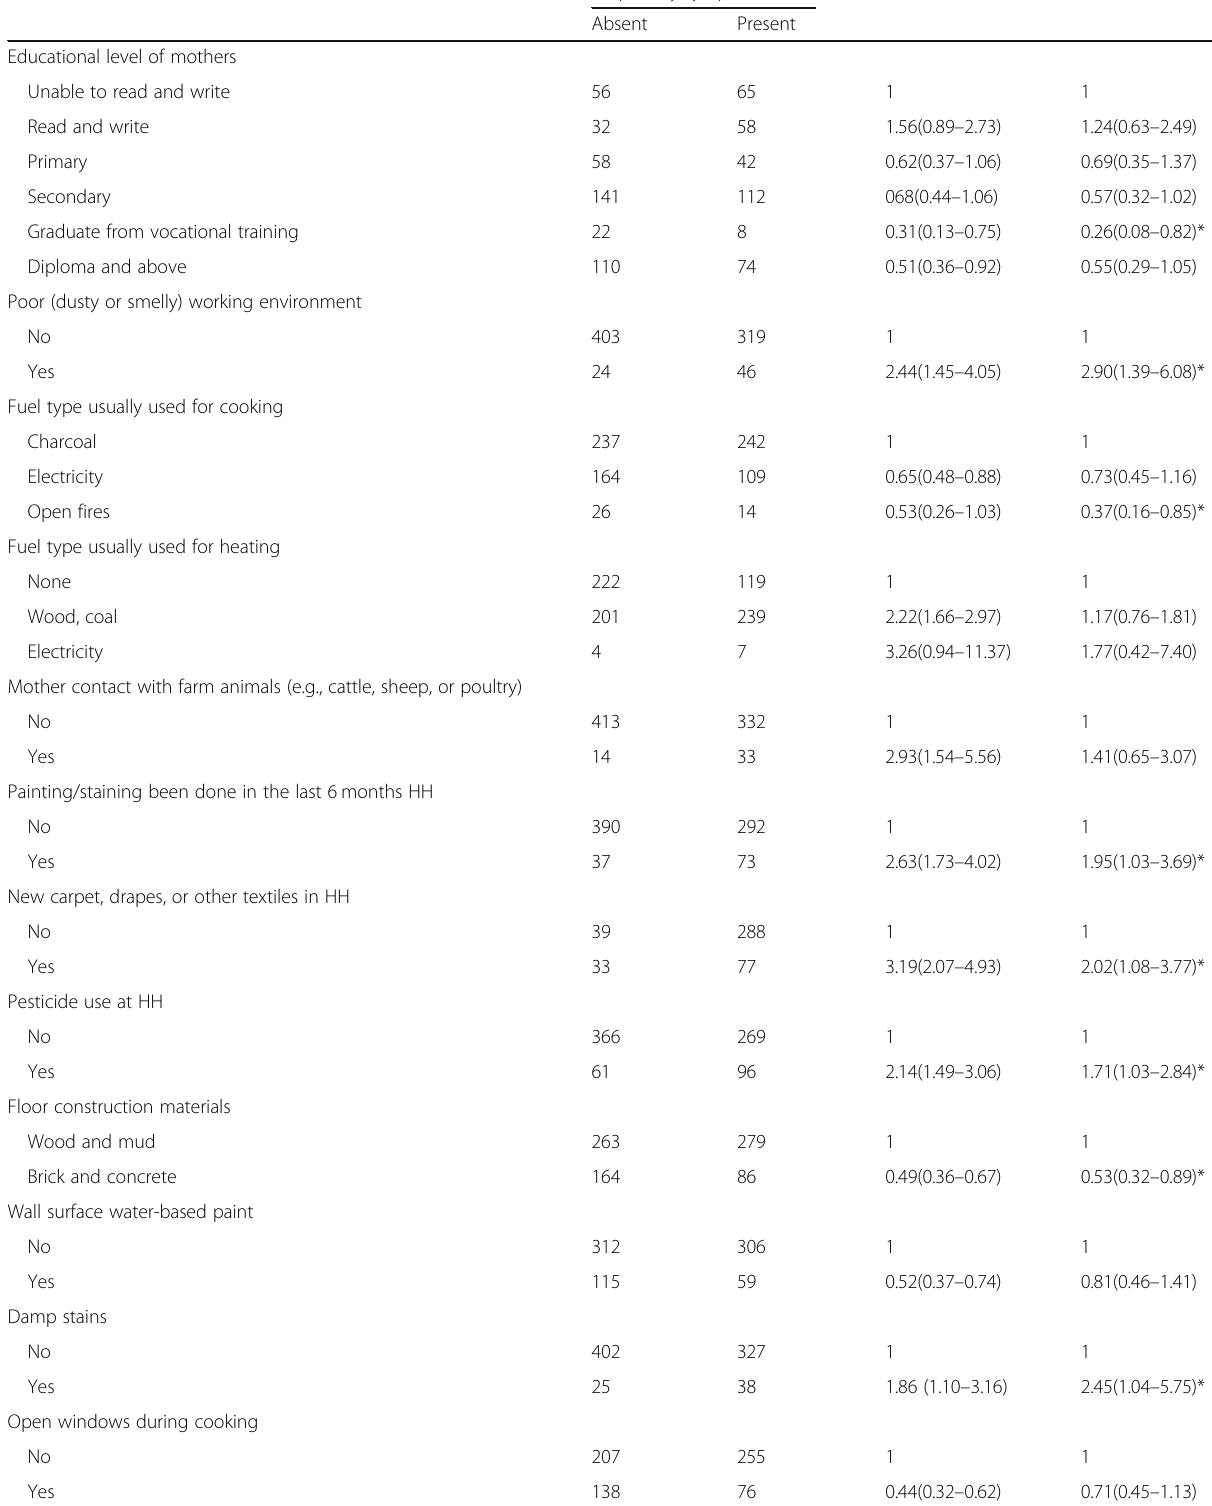
Table 3 Factors associated with mothers ’ respiratory symptoms in Gondar city northwest Ethiopia,